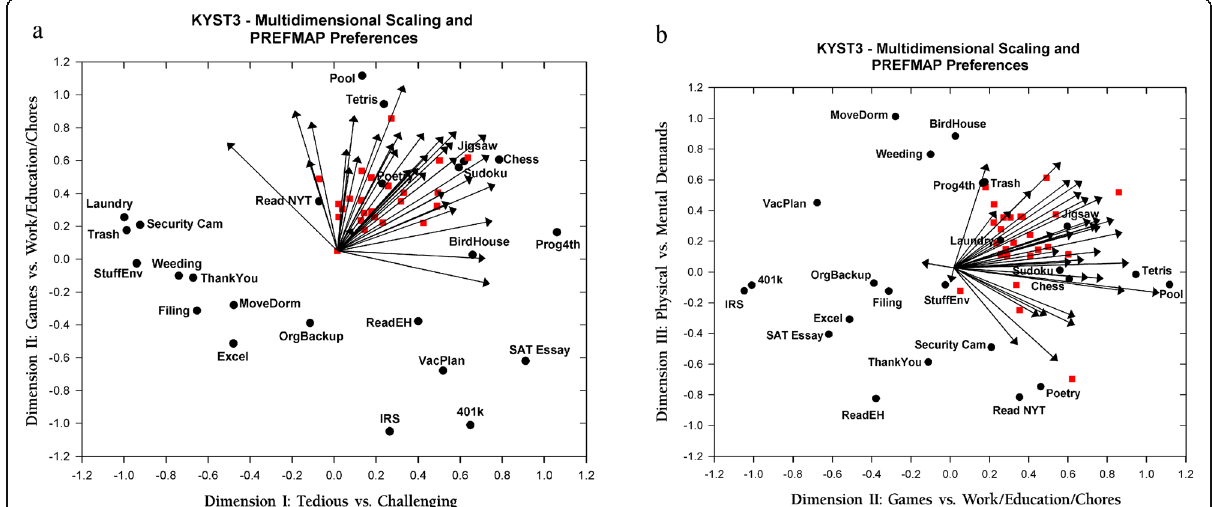
Fig. 2 Multidimensional scaling solution and preferences (vectors and ideal points). a Dimension I (Tedious vs. Challenging) vs. Dimension II (Games vs. Work/Education/Chores). b Dimension II (Games vs. Work/Education/Chores) vs. Dimension III (Physical vs. Mental Demands). Tasks are shown as black circles . Preference vectors are shown as arrows . Ideal points are shown as red squares . N =